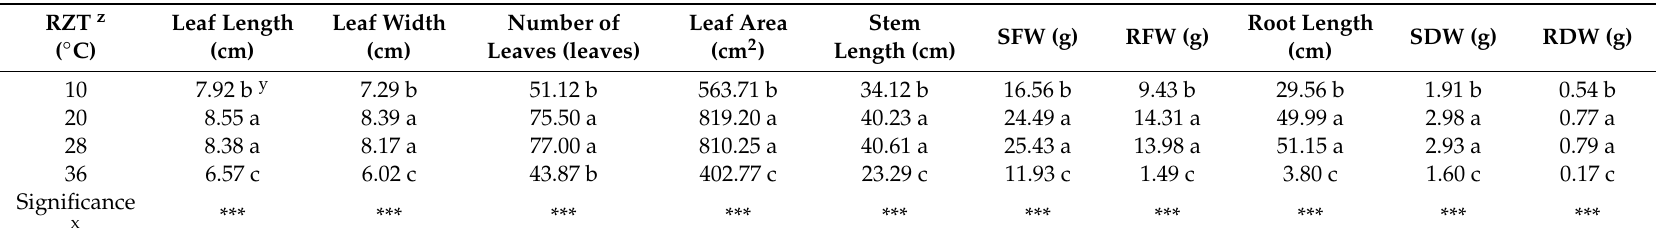
Table 1. Plant growth parameters of A. rugosa grown at four di ff erent root zone temperature (RZT) treatments (10, 20, 28, and 36 ◦ C) at 32 days after transplant. RZT z Leaf Length ( ◦ C)